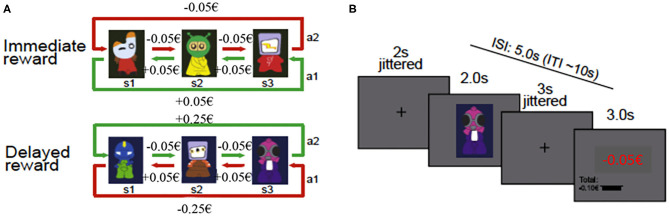
Schematic illustration of task design and trial procedure. (A) Task design of the three-state Markov decision task showing the two reward conditions (immediate and delayed) with the respective state transition structure (from Wittkuhn et al., 2018 Copyright 2020 by Elsevier). (B) Figure of the trial procedure (from Eppinger et al., 2015 Copyright 2020 by Elsevier). ISI, interstimulus interval; ITI, intertrial interval.